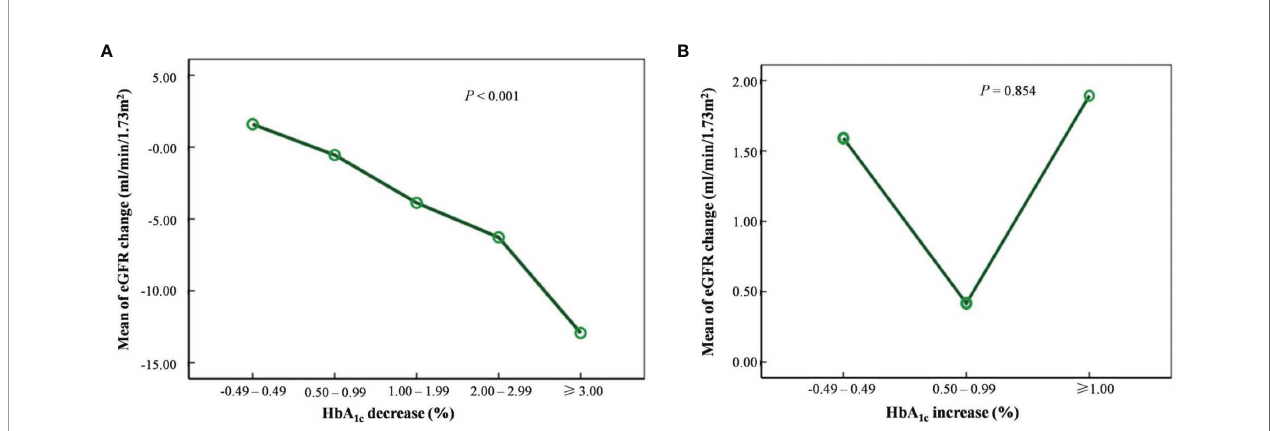
FIGURE 2 | Trend of estimated glomerular fi ltration rate (eGFR) change in different HbA 1c decrease (A) and increase (B) groups.